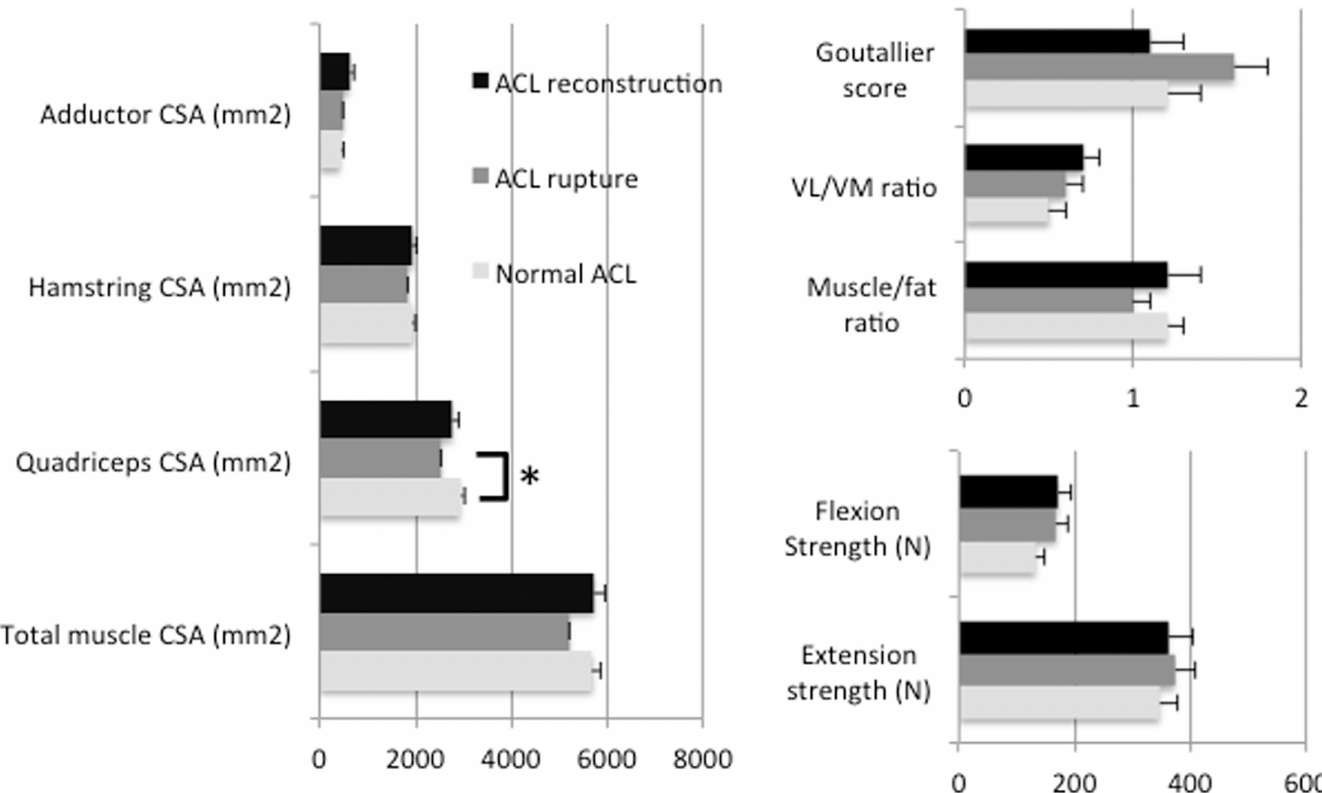
Fig 2. Muscle characteristics. Mean ± SEMare given for the different ACL groups, controllingfor the co-variates age, genderand BMI. ACL, anterior cruciate ligament;CSA, cross-sectional area; VL, vastus lateralis muscle; VM, vastus medialis muscle. * P <